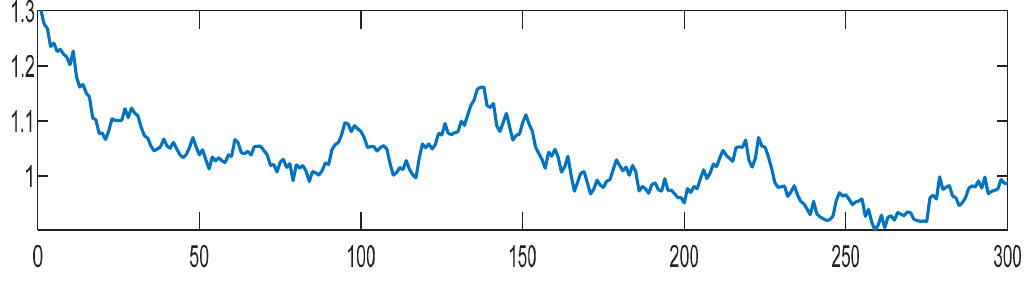
Figure A3. Selected mean value decrease scenario of gas prices.